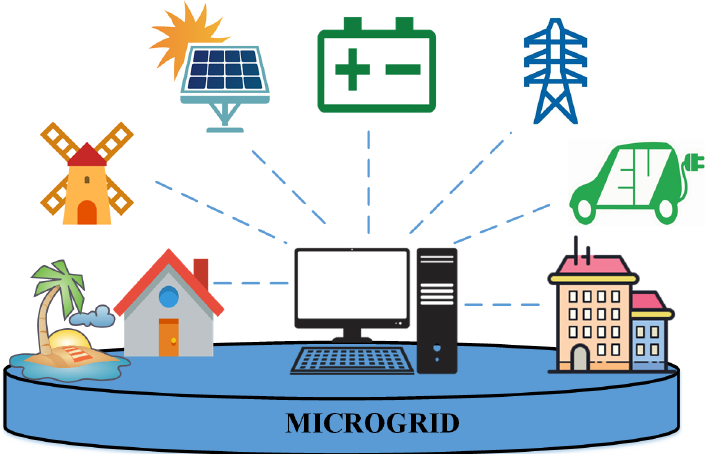
Figure 1. A schematic diagram of a microgrid.